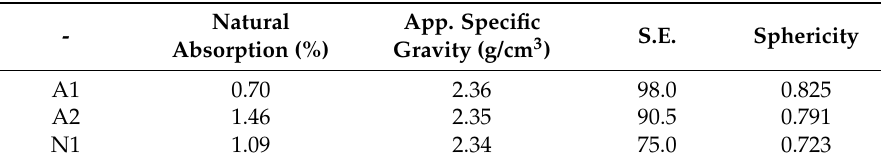
Table 1. Physical properties of the sands.